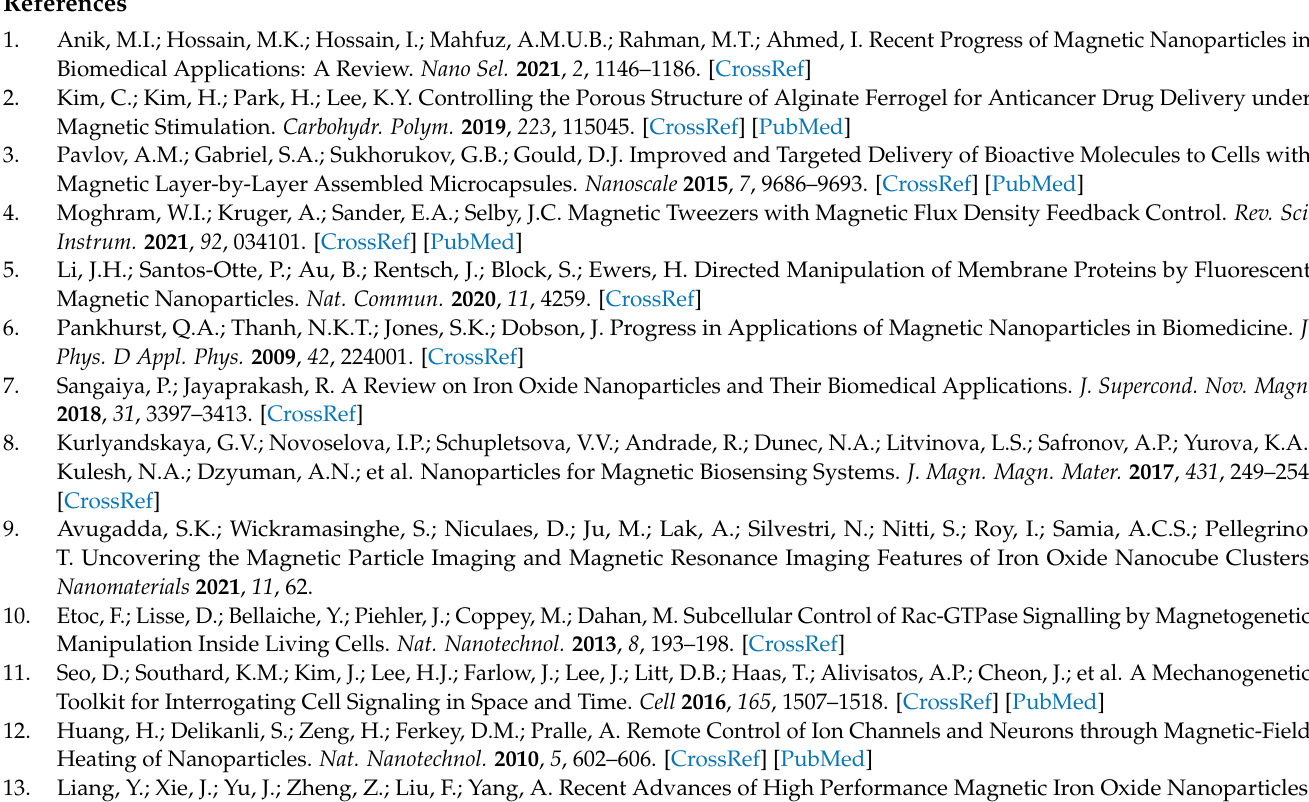
ticles with three surface modifications. Figure S2: Qualitative assessment of the colloidal stability for synomag nanoparticles over time from 1 min up to 1